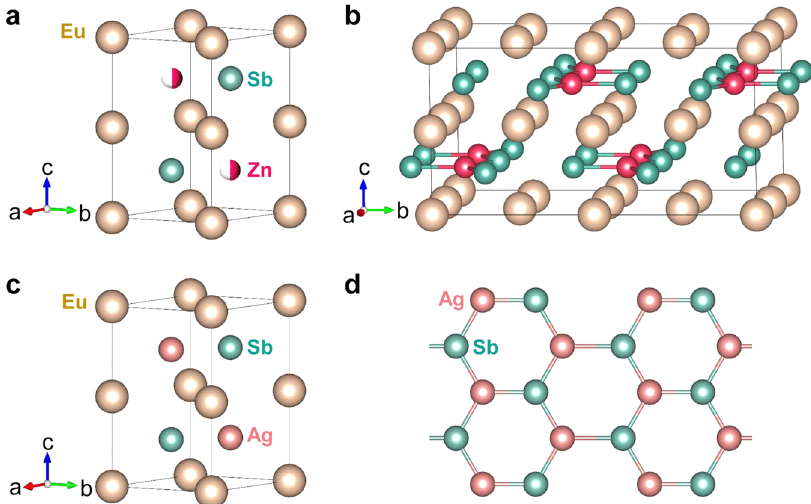
Fig. 1 Crystal structures. a Crystal structure of Eu 2 ZnSb 2 . The golden, green, and red spheres represent the europium, antimony, and zinc, respectively. b